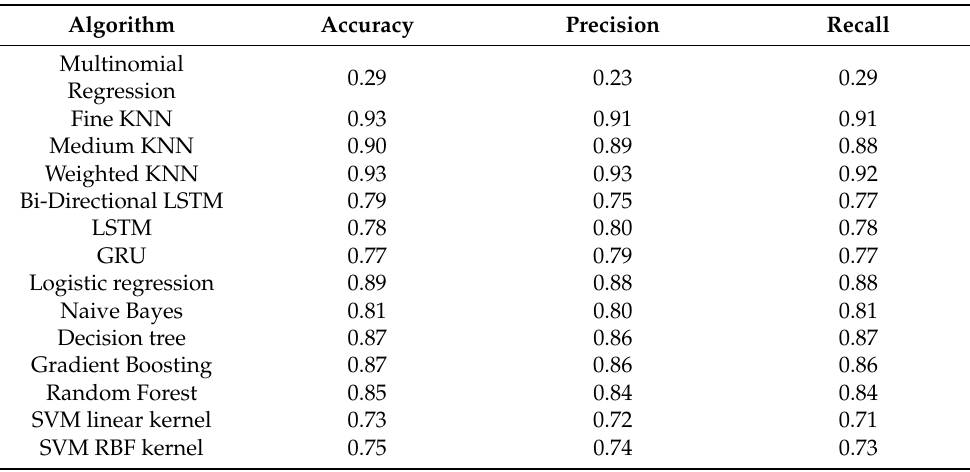
Figure 8. Accuracy, precision, and recall for various machine learning algorithms. Table 7. Summary of the results for di ff erent KNN algorithms. Table 8. Accuracy, precision, and recall for various machine learning algorithms.